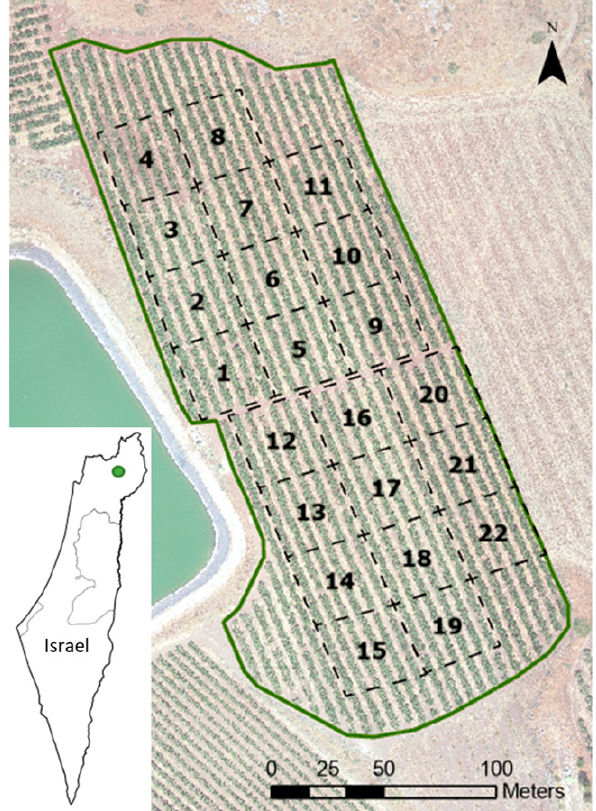
Figure 1. Mishmar Hayarden peach orchard (green line) divided into 22 management cells (MC) (black dashed squares).